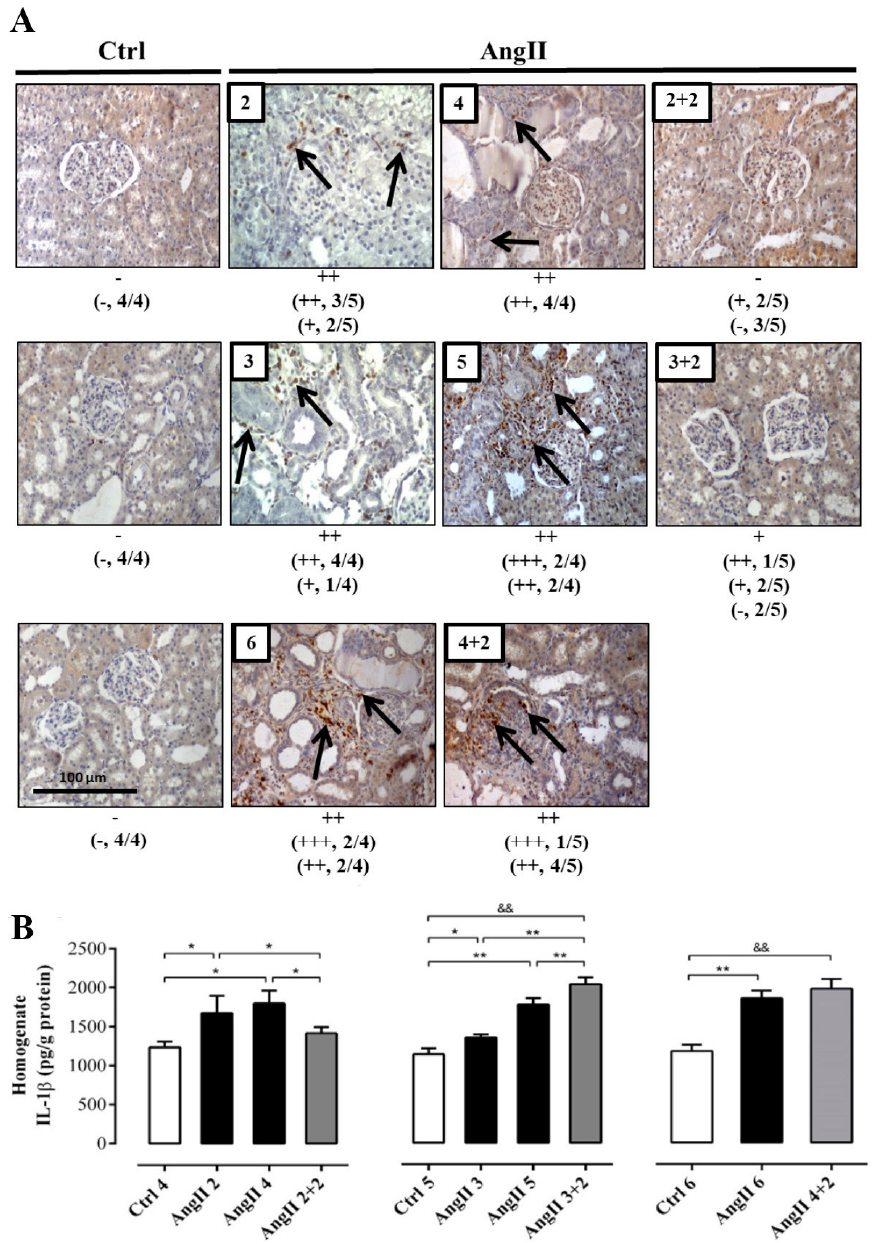
Figure 4. The amounts of ED-1 and IL-1 β remain high in rats treated with AngII for 4 weeks. Immunostaining for ED-1 were performed in renal samples ( A ). Representative pictures of at least three di ff erent kidneys and four di ff erent fields are shown. Scale bar = 100 µ m. Brown staining represents ED-1 positive immunoreactivity. The staining is indicated by black arrows. The semi-quantitative morphometric analysis for ED-1 was performed as explained in the Materials and Methods. Renal homogenates were used to measure IL-1 β as marker of inflammation ( B ). The bars represent the means ± SE of a n ≥ 4 rats per experimental group. The di ff erences between the subgroups of each of the three groups were evaluated by an ANOVA followed by a Tuckey test. ** p < 0.01 and * p < 0.05 vs. AngII groups; && p < 0.01 vs. AngII 3 + 2 and AngII 4 +